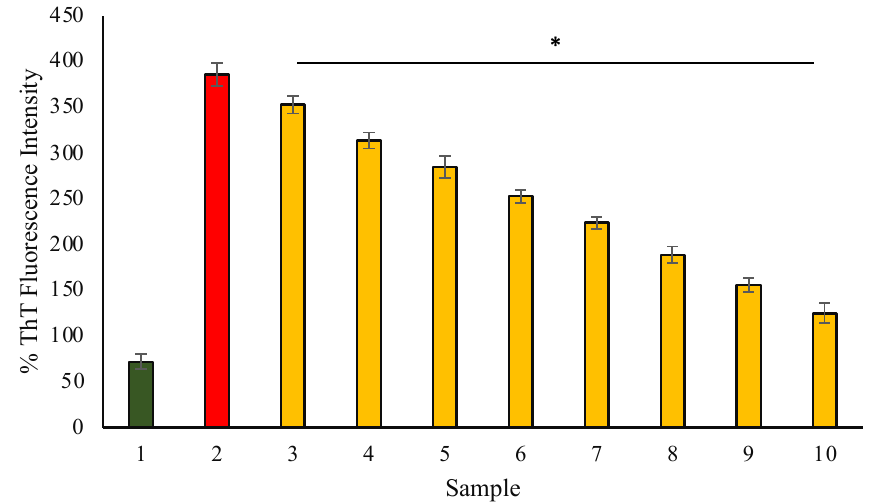
Figure 11. Fluorescence intensity at 480 nm vs. Sample—Sample 1 (green pattern) shows native BSA that was incubated alone for 15 days, sample 2 (red pattern) represents BSA kept with glucose in the absence of myrrh extract for 15 days, samples 3 to 10 at X-axis indicate BSA kept for 15 days with glucose and myrrh extract’s various concentrations (50, 75, 100, 200, 300, 400, 500, and 600 µg/mL) (yellow pattern). The data are shown as means ± standard error of the means (n = 3, p < 0.05). The statistical differences are represented with an asterisk (*) for myrrh denoting significance at p < 0.05 in comparison with the reference sample.